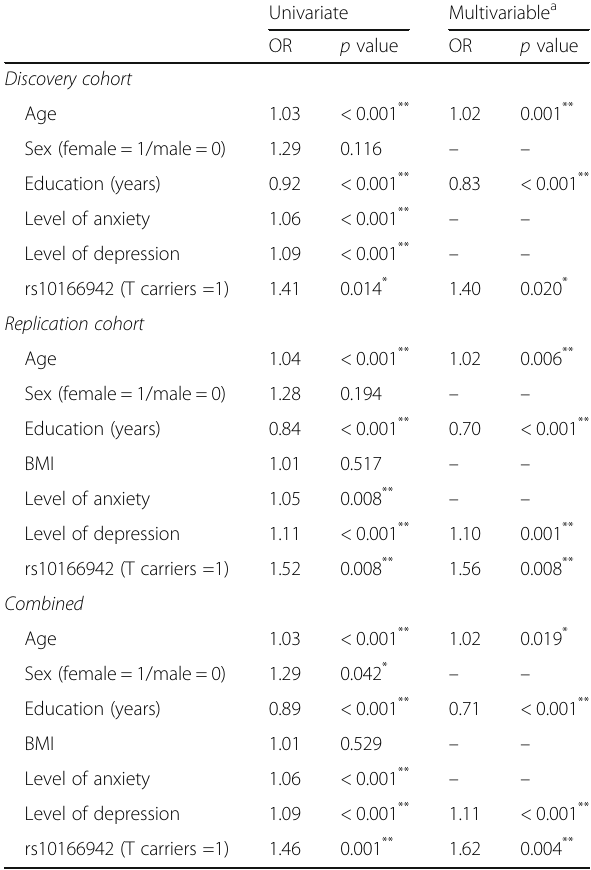
Table 3 Demonstration of the associations between chronic migraine and rs10166942 genotypes by logistic regression models